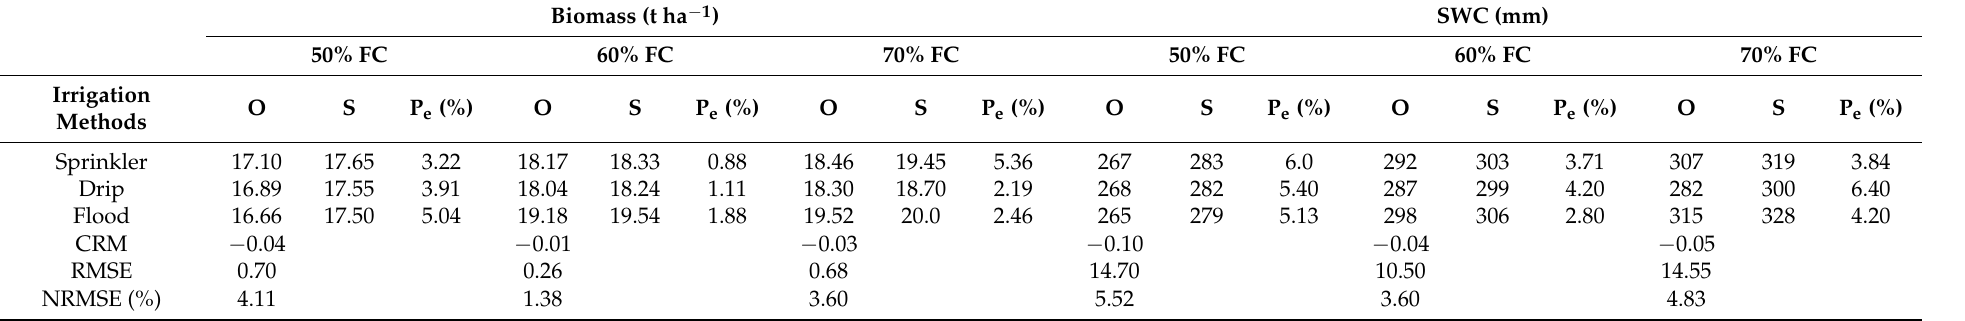
Table 10. Validation results of biomass and soil water content (SWC) under different irrigation strategies in 2017 −